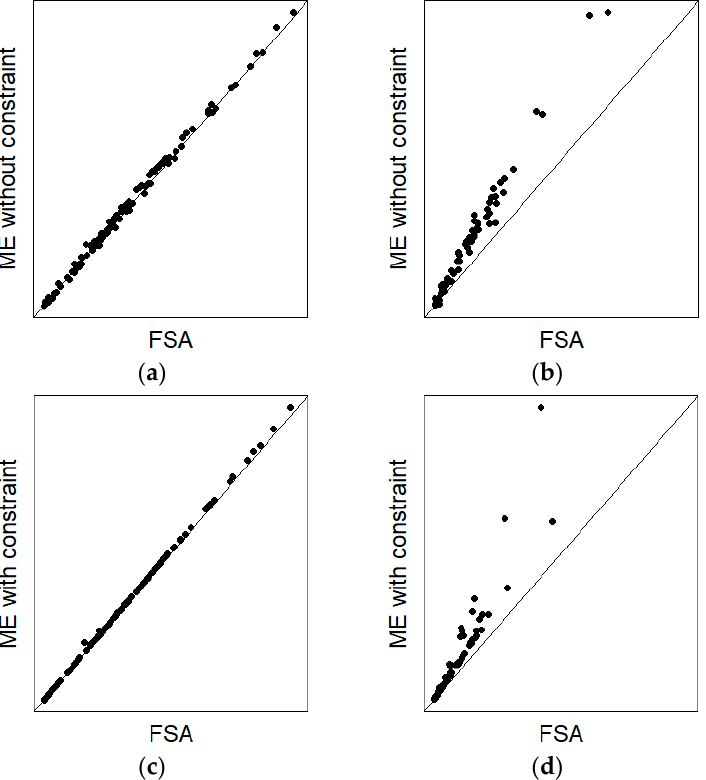
Figure 4. A plot of the modeled county estimates of acres planted to corn versus the acres planted to corn reported to the FSA for ( a ) Illinois and ( b ) Pennsylvania when the constraint that the estimate must be at least as large as the FSA reported value is not included in the model and for ( c ) Illinois and ( d ) Pennsylvania when the constraint is included in the model.